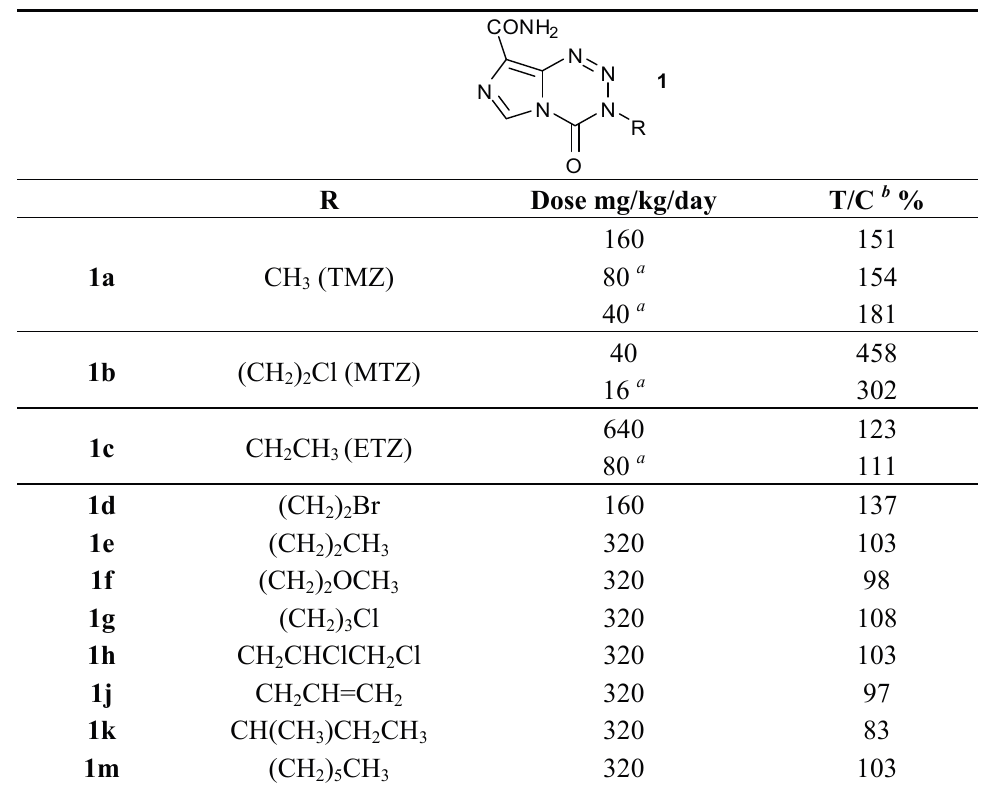
Table 1. Activity of various TMZ analogues against TLX5 lymphoma implanted s.c. in CBA/CA mice. Adapted with permission from reference [9]. Copyright (1987) American Association for Cancer